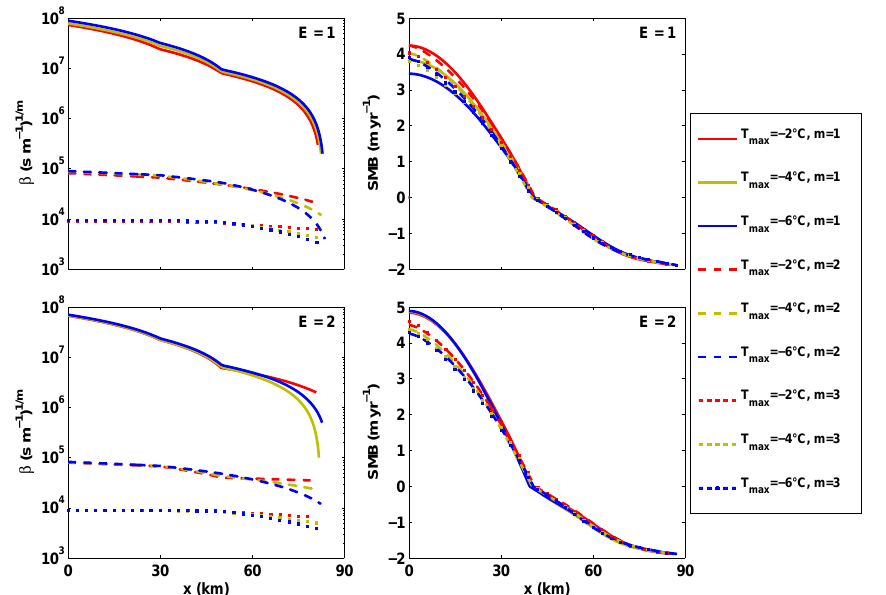
Fig. 1. Profiles of the (left) basal roughness factor, β , and (right) surface mass balance, SMB, for the 18 model simulations performed using the seaward-dipping bed profile. The basal roughness factor is plotted using a logarithmic scale to highlight the dependence of the chosen piecewise linear functions on m . The data are divided according to the enhancement factor, E , in order to highlight the differences between (top panels) normal, E = 1, and (bottom panels) enhanced, E = 2, ice deformation. Different colors distinguish the maximum ice temperature ( T max ) used to calculate the rate factor profiles: red indicates T max =− 2 ◦ C, yellow indicates T max =− 4 ◦ C, and blue indicates T max =− 6 ◦ C. The line style distinguishes the choice of m : solid lines indicate m = 1, dashed lines indicate m = 2, and dotted lines indicate m = 3.